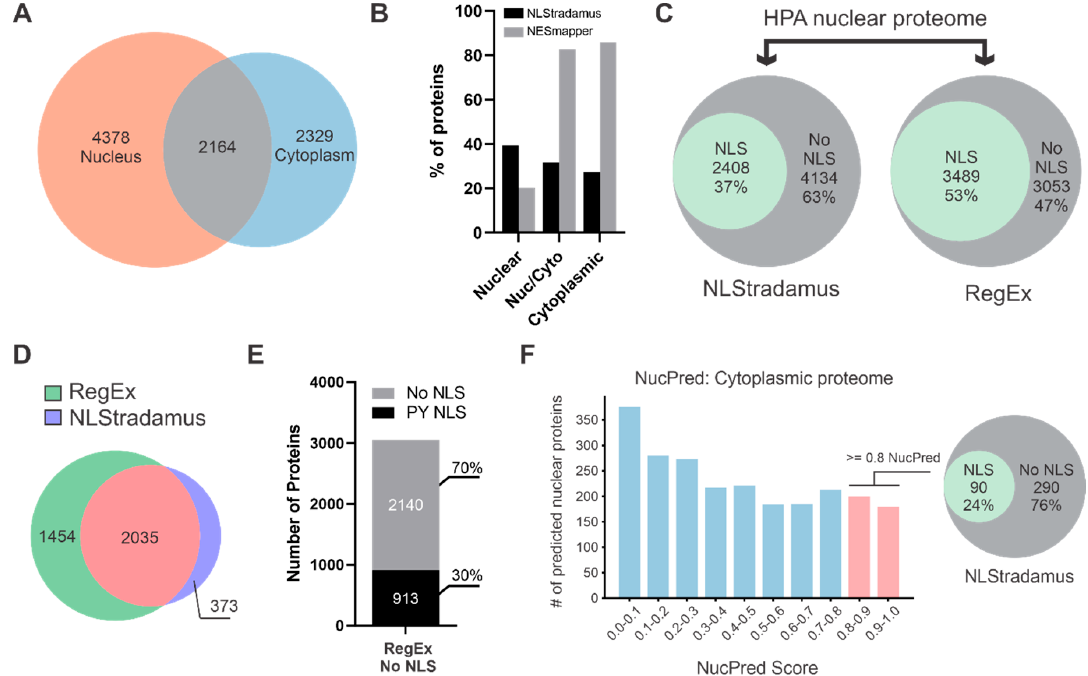
Figure 1. The majority of human nuclear proteins do not contain a predictable cNLS. ( A ) Nuclear and cytoplasmic proteins were retrieved from the Human Protein Atlas (HPA) for the identification of distinct nuclear, cytoplasmic and nucleocytoplasmic proteins. ( B ) cNLS and NES prediction of nuclear, nucleocytoplasmic (Nuc/Cyto) and cytoplasmic proteins from the HPA using NLStradamus and NESmapper, respectively. The majority of Nuc/Cyto and cytoplasmic proteins have a predictable NES in contrast to nuclear and Nuc/Cyto proteins where the majority do not have a predictable cNLS. ( C ) Comparison of cNLS prediction approaches using NLStradamus and regular expression matching (RegEx) on nuclear proteins from the HPA. All motifs corresponding to cNLSs in the eukaryotic linear motif database were used for RegEx matching, where any protein with at least one match is counted as a hit. Comparing approaches shows that somewhere between 47% and 63% of nuclear proteins do not have a predictable cNLS. ( D ) The prediction of proteins with a cNLS using either RegEx matching or NLStradamus demonstrates significant overlap. The majority of NLStradamus predictions are also predicted by RegEx matching. ( E ) Proteins without a cNLS, as determined by RegEx matching, were searched for a minimal PY-NLS (R/H/K-X 2-5 -PY), demonstrating that a substantial portion of nuclear proteins also do not contain a PY-NLS. ( F ) Cytoplasmic proteins were analyzed with NucPred to predict nuclear localization and those with a score greater than 0.8 were searched for cNLSs. Those with a cNLS are considered to have a high probability of nuclear localization, highlighting the potential for additional nucleocytoplasmic localizations not supported by the HPA. NLStradamus for NLS prediction and NESmapper for NES prediction, indicated that NLSs are more frequently predicted in nuclear proteins and NESs are more frequently predicted in cytoplasmic proteins, as anticipated (Figure 1B). The difference in frequency of identifying a predicted cNLS for nuclear proteins or a predicted NES for cytoplasmic proteins is particularly intriguing. Over 80% of cytoplasmic proteins have a predictable NES, while only ~40% of nuclear proteins have a predictable cNLS.